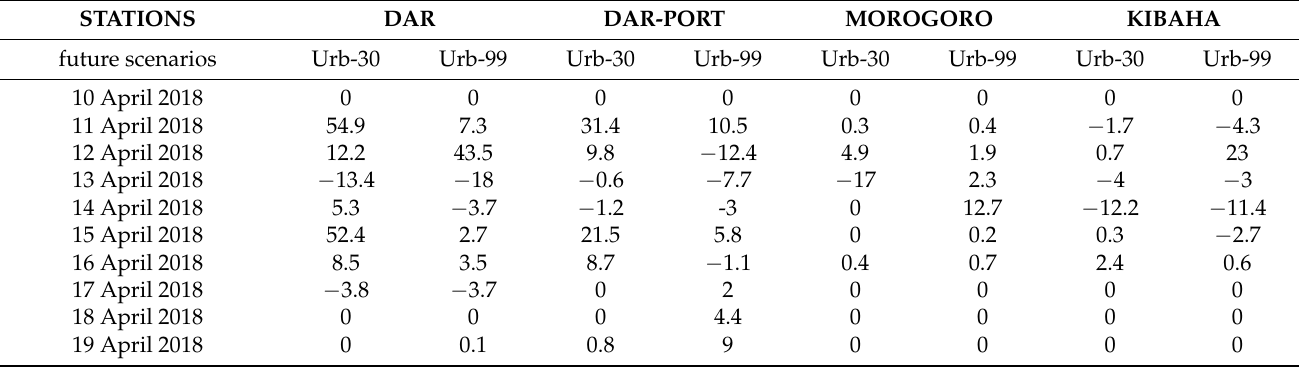
Table 4. Daily precipitation difference (mm d − 1 ) between future urbanization scenarios and current LULC at four stations. STATIONS DAR DAR-PORT MOROGORO KIBAHA future scenarios Urb-30 Urb-99 Urb-30 Urb-99 Urb-30